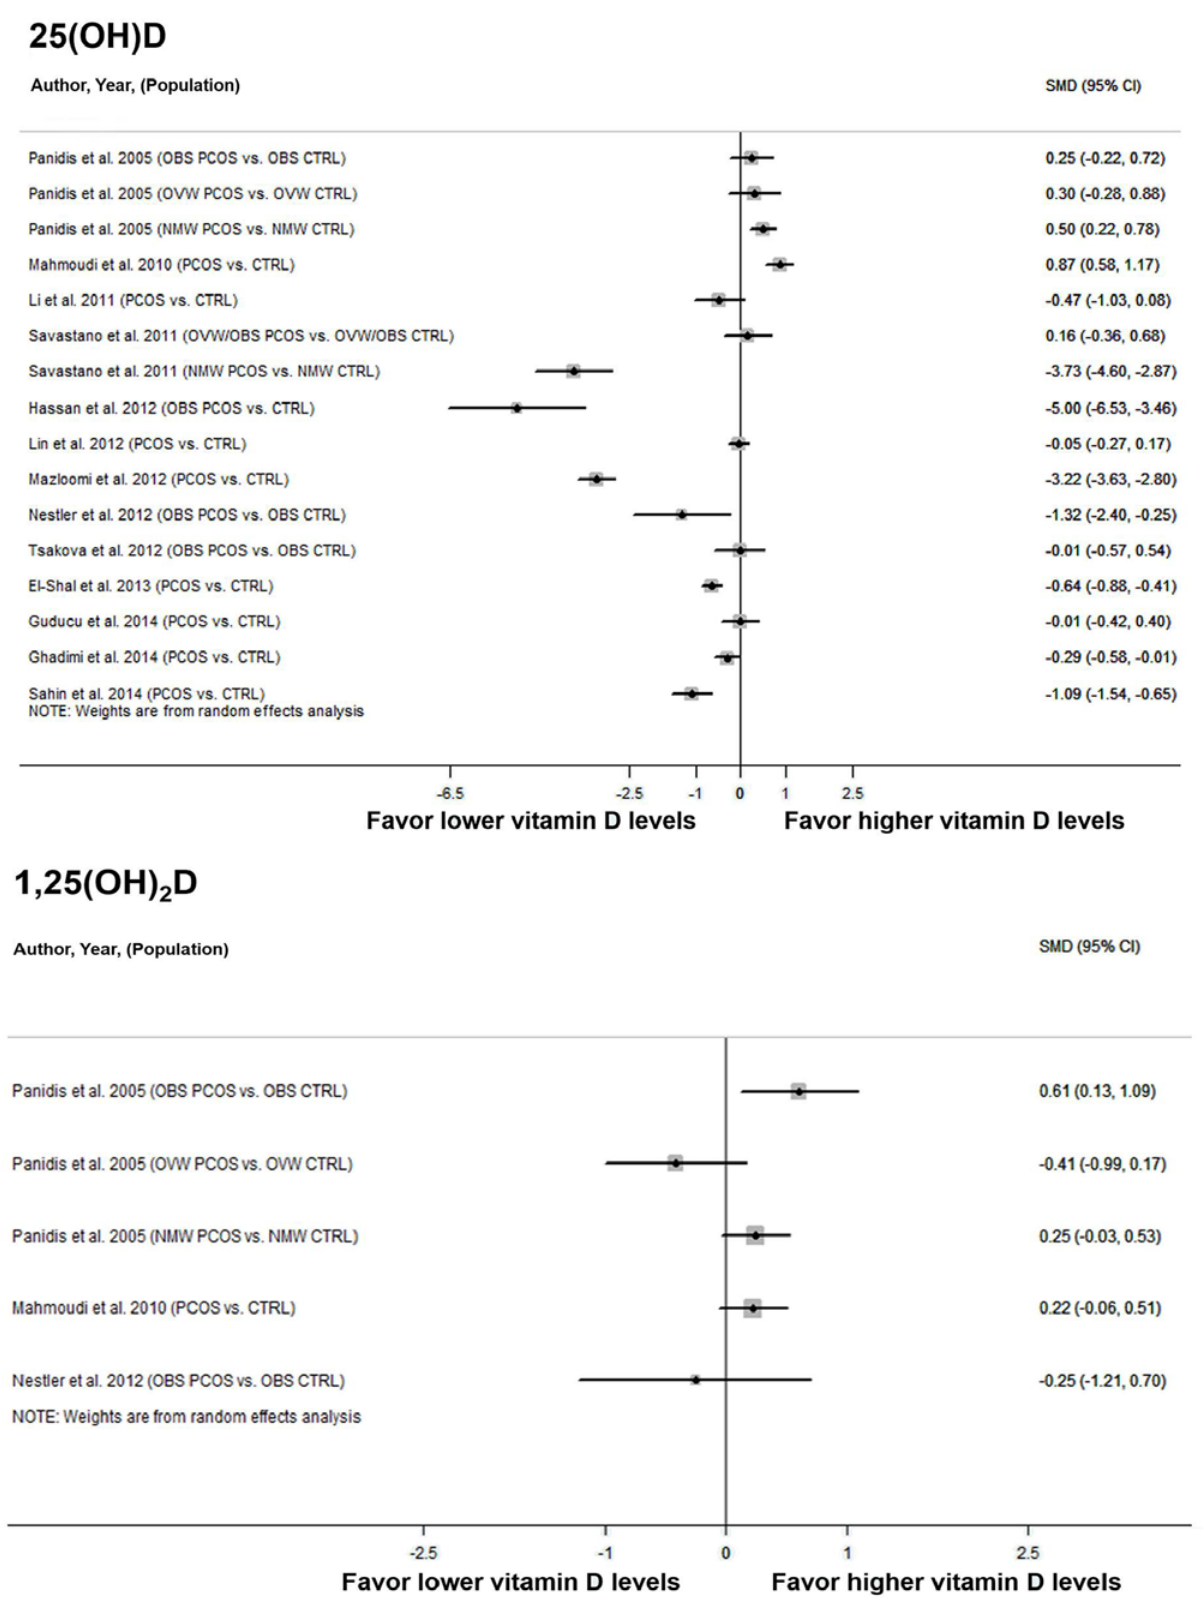
Figure 2. Forest plots showing the effect size of the association between serum vitamin D levels and PCOS in women (SMD, standardized mean difference; OBS, obese; OVW, overweight; NMW, normal weight; PCOS, polycystic ovary syndrome; CTRL,